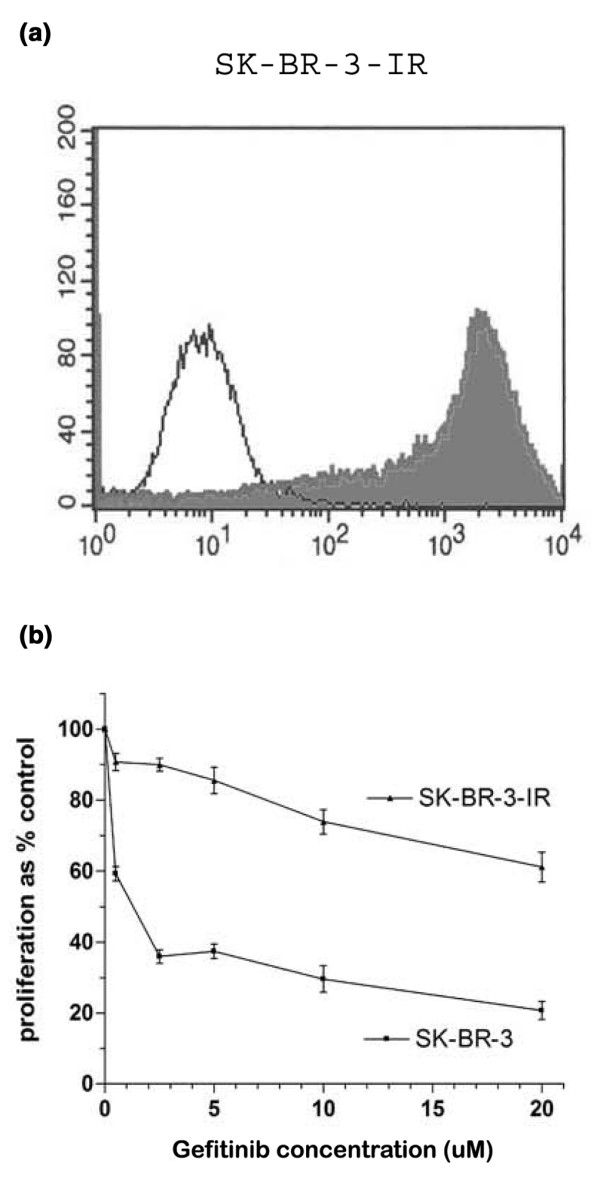
Overexpression of IGF-1R results in enhanced resistance to gefitinib antiproliferation activity. (a) Flow cytometry estimation of surface expression levels of epidermal growth factor 1 receptor (IGF-1R) (shaded peak) in the SK-BR-3-IR line, which differs from its parental line, SK-BR-3, only by the transfected IGF-1R gene [12]. Outlined peak is normal mouse IgG1 isotype. Counts indicate number of events. (b) Effect of a 72-hour treatment with gefitinib alone on the proliferation of SK-BR-3 and SK-BR-3-IR cells. Triplicates were used for each dose.